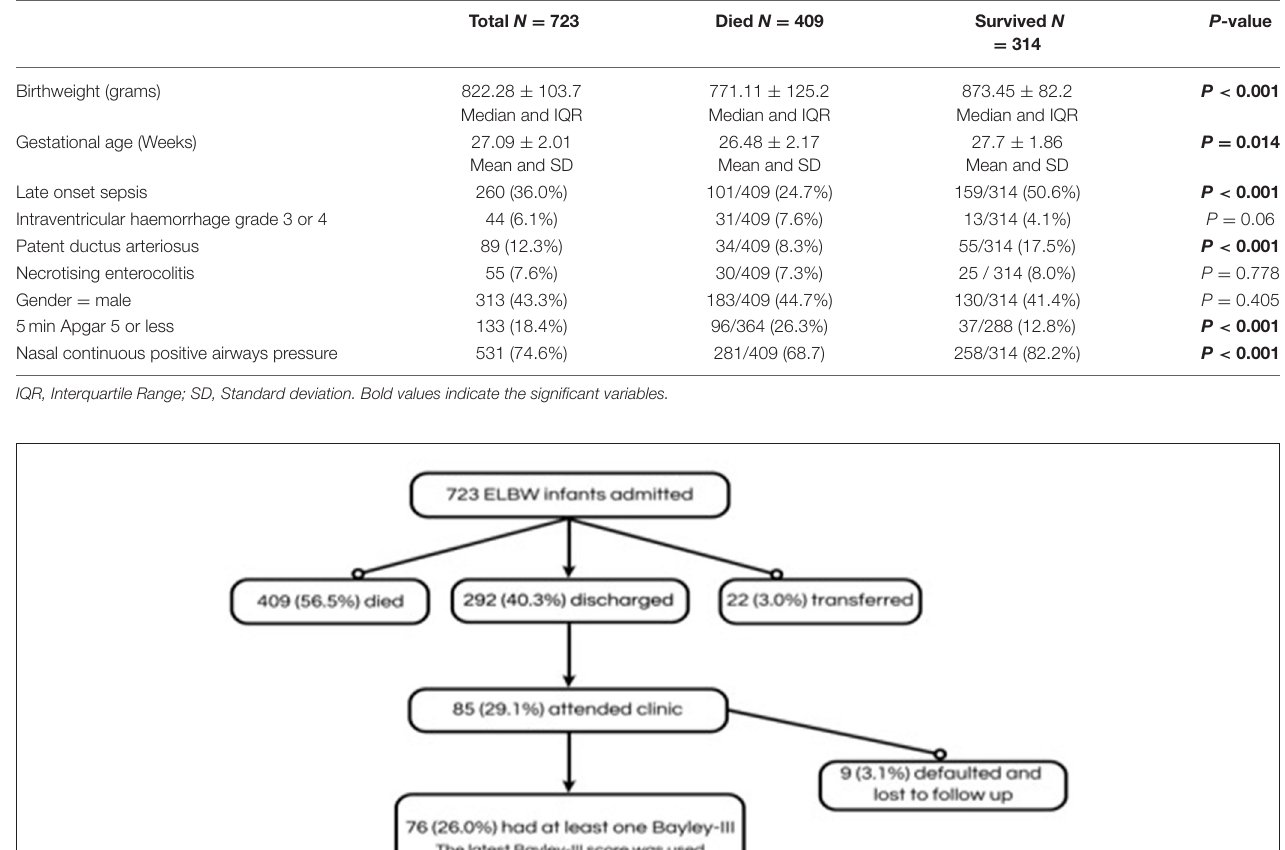
TABLE 1 | Clinical characteristics and risk factors associated with mortality in ELBWI at a tertiary hospital in Johannesburg, South Africa.